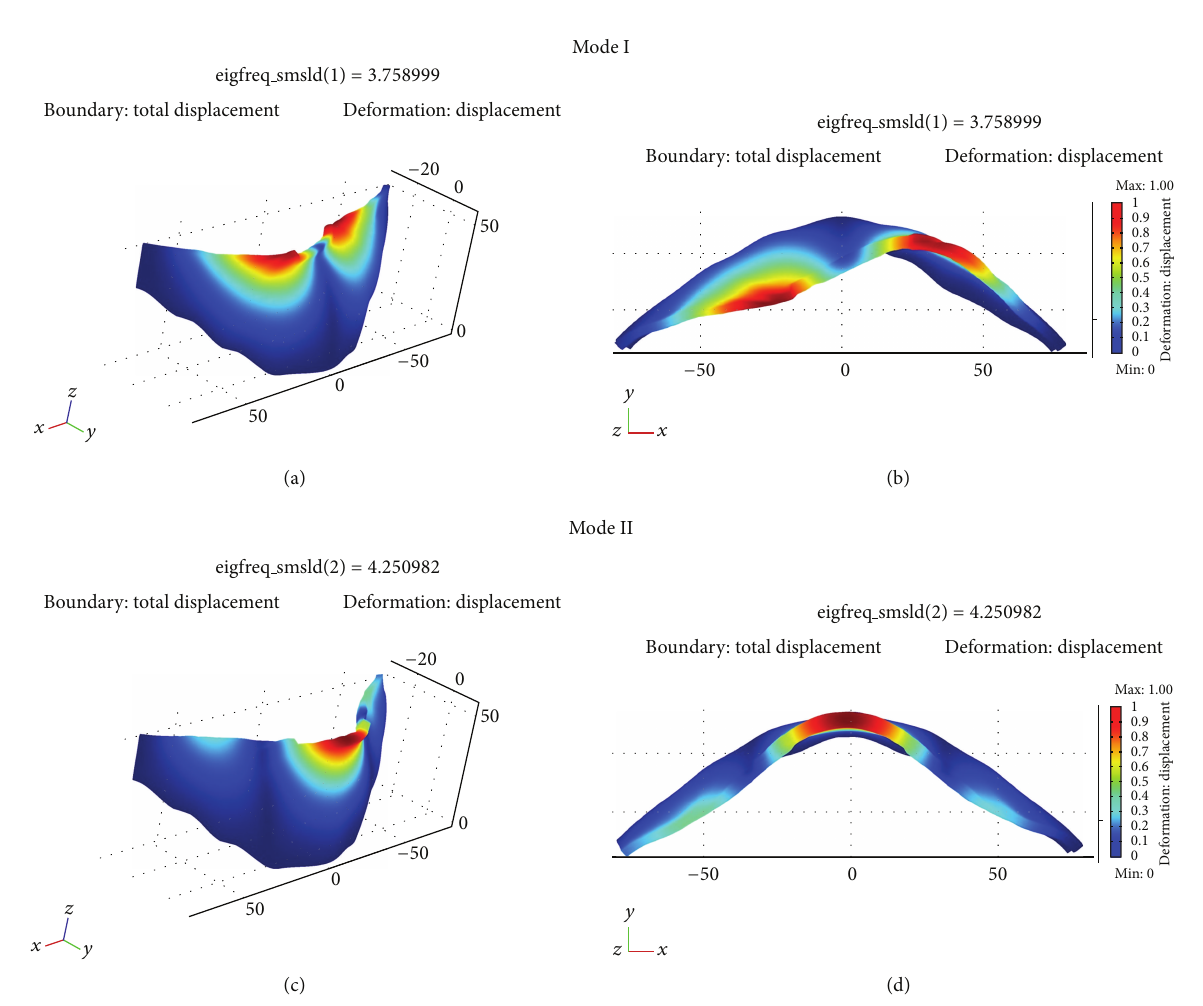
Figure 16: First two mode shapes of vibration according to Punta Gennarta Dam model: (a, c) perspective view; (b, d) horizontal plane view. The color scale indicates the normalized total displacement of each mode